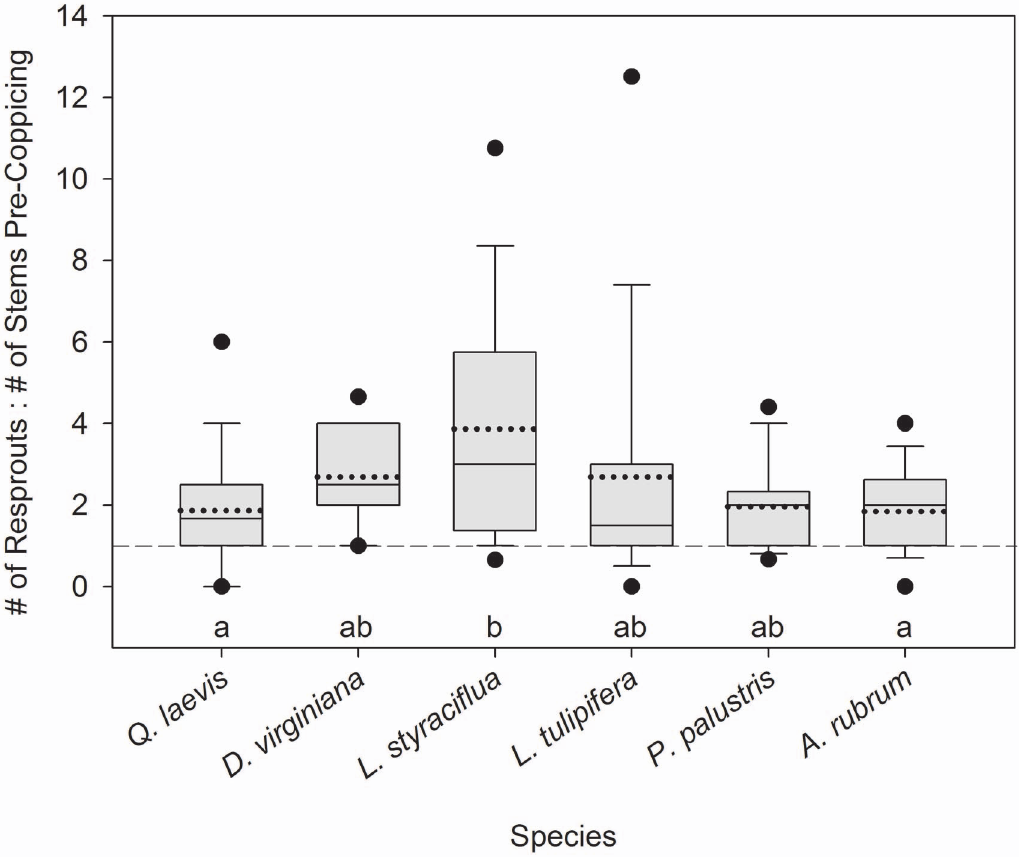
Figure 2. Ratio of resprout stem number to pre-coppicing stem number. In the boxplots, the solid and dotted bars represent the median and mean, respectively; the lower and upper bars represent the 25 th and 75 th percentiles, respectively. The lower and upper ‘‘whiskers’’ show the largest and smallest values that are not outliers and the lower and upper dots show the 5 th and 95 th percentiles. Kruskal-Wallis X 2 =20.03, P =0.001; different letters indicate significant differences among species. The dashed line indicates where the number of resprouts equals the number of stems pre-coppicing.